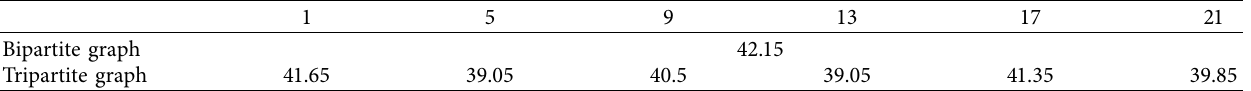
Table 2: Comparison of novelty.